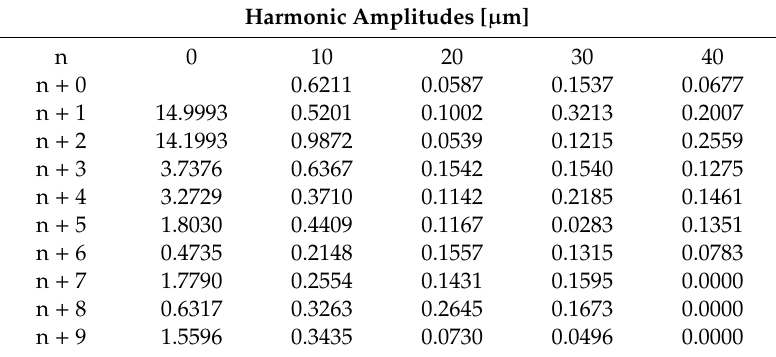
Table 10. Amplitudes of harmonic components for the profile obtained by superimposing the measured roundness profile of journal no. 5—and rotating it by 90 ◦ with respect to the reference profile—onto the profile of the eccentric movement of the center of the measured roundness profile with the supports set at the same height ( x = 0 mm), with an eccentricity of the main journal e = 0.03 mm. Harmonic Amplitudes [ µ